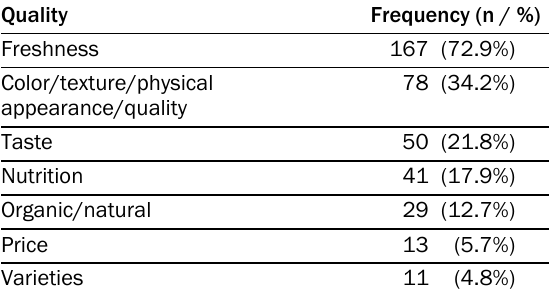
Table 5. Qualities of Vegetables Preferred by